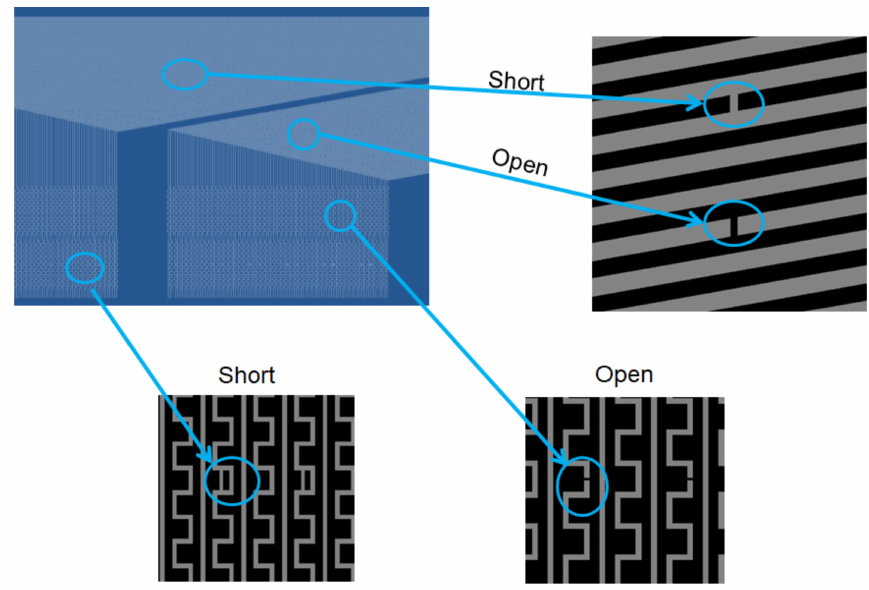
Figure 11. Verify at open and short defect on the left area of the photomask for AOI. On the other hand, the experiment also utilizes the color area-CCD to magnify TFT defect for further inspection. The AOI installed a set of area-CCD at the diagonal length of 1/2 inches to take the image of the dimensional area for the field of view (FOV). The lens engaged with the various magnification for 2 × , 5 × , 10 × , 20 × , and 50 × , respectively. Figure 12 indicates several images concerning the magnification at the upper right corner. Moreover, higher magnification results from the image quality due to vibration, whereas antivibration is another issue for AOI. The AOI platform installed the pneumatic caution to prevent the vibration, which the cause is the most by an unstable foundation or resonance equipment in the factory.